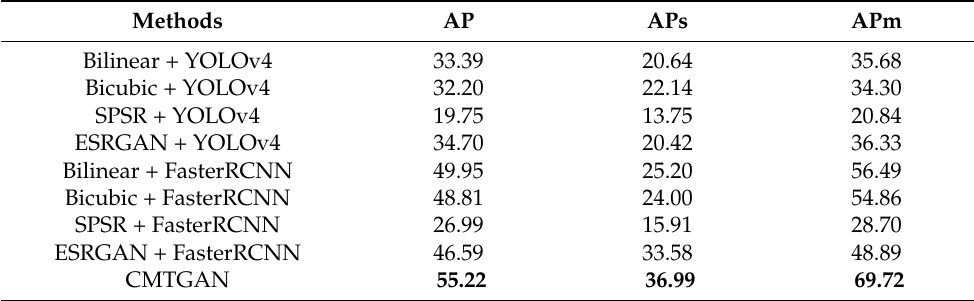
Table 6. Performance of object detection.